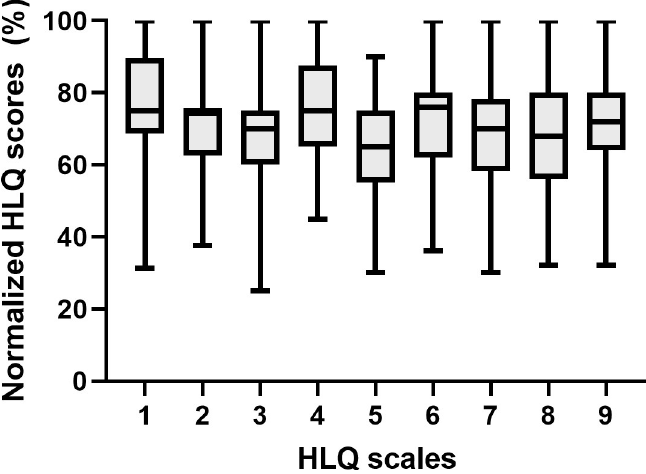
Fig 1. Median of normalized health literacy scores of each scale as assessed by HLQ. Higher scores indicate higher health literacy levels (error bars ranges). (HLQ: health literacy questionnaire; Scale 1: Feeling understood and supported by healthcare providers (HPS); scale 2: Having sufficient information to manage my health (HIS); scale 3: Actively managing my health (AMH); scale 4: Social support for health (SS); scale 5: Appraisal of health information (CA); scale 6: Ability to actively engage with healthcare providers (AE); scale 7: Navigating the healthcare system (NHS); scale 8: Ability to find good health information (FHI); scale 9: Understand health information well enough to know what to do